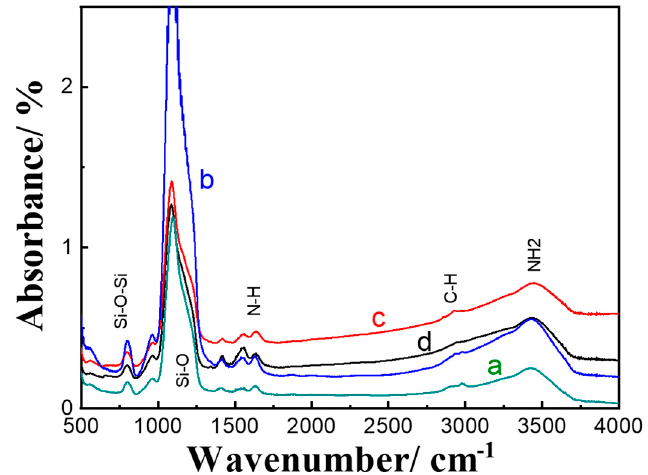
Figure 3. FTIR spectra of MSN-NH 2 prepared with different volumes of APTES: (a) 50 µL, (b) 75 µL, (c) 100 µL, and (d) 150 µL.